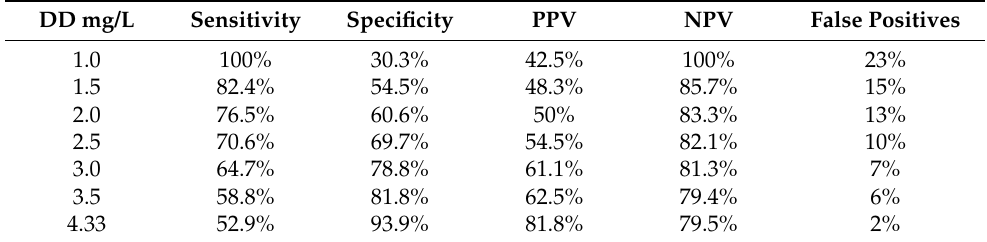
Table 3. D-Dimer values in the geriatric population with PE and COVID-19.